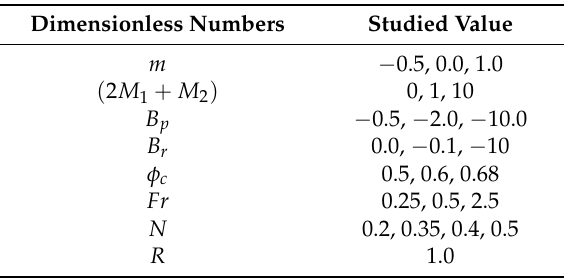
(a) (b) Figure 3. The effect of 𝜙 (cid:3030) on the velocity profile ( a ) and the volume fraction profile ( b ), when 𝑅 = 1 , 𝑚 = 1 , (2𝑀 (cid:2869) + 𝑀 (cid:2870) ) = 1 , 𝐵 (cid:3043) = −1 , 𝐵 (cid:3045) = −10 , 𝑆 = 100 , 𝐹𝑟 = 0.5 , 𝑁 = 0.4 .